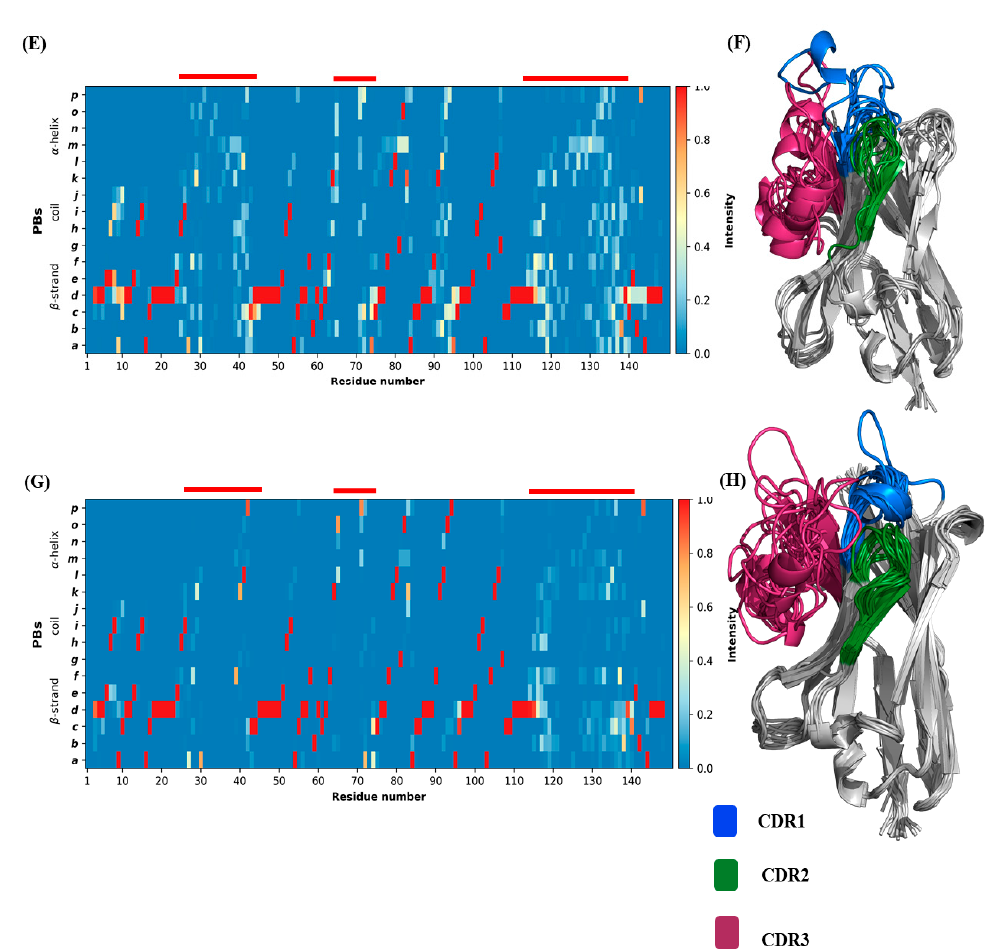
Figure 10. Representation of backbone conformations from trajectories clustered using average Δ PB. ( A , C , E , G ) are PB maps of the four Δ PB clusters, ( B , D , F , H ) are the visualisation of the structures.